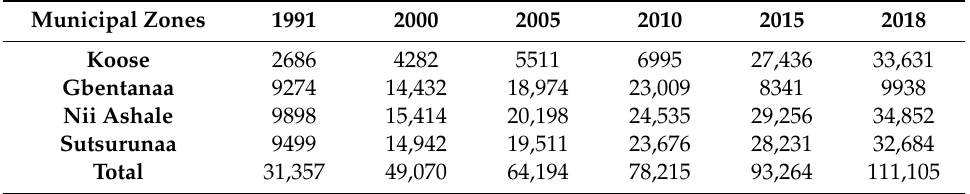
Table 3. Population distribution of Adenta municipality represented in their